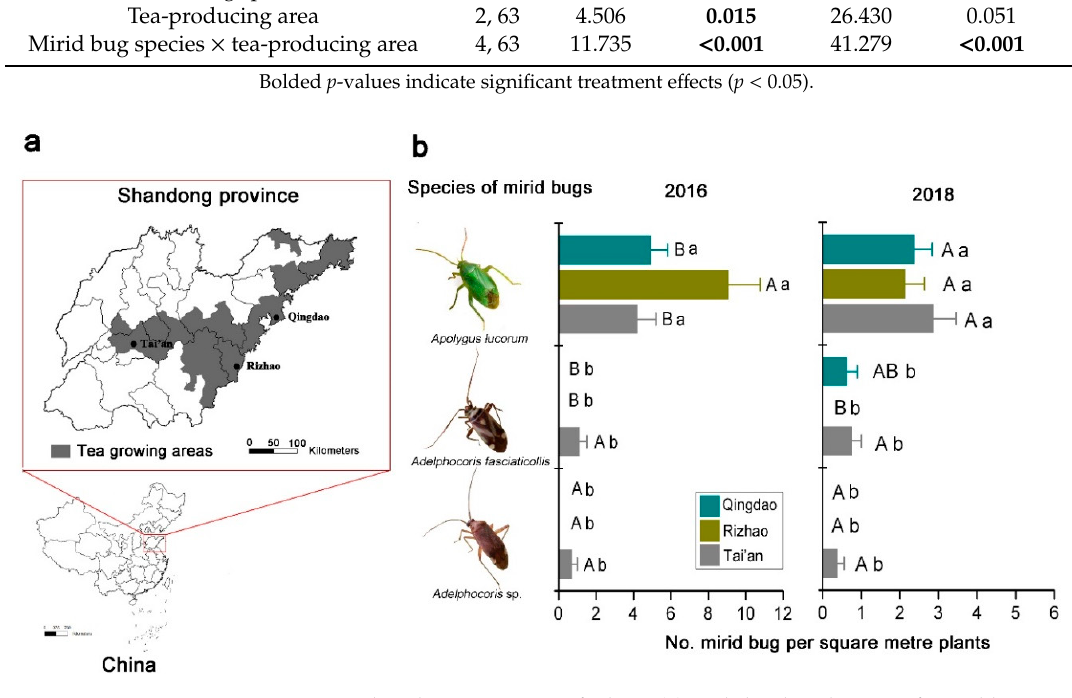
Figure 2. Tea growing areas in Shandong province of China ( a ) and the distribution of mirid bugs in three tea-producing areas in Shandong Province in 2016 and 2018 ( b ). Di ff erent uppercase and lowercase letters indicate significant di ff erences among di ff erent tea-producing areas and di ff erent mirid bug species, respectively (Tukey’s HSD test, p <